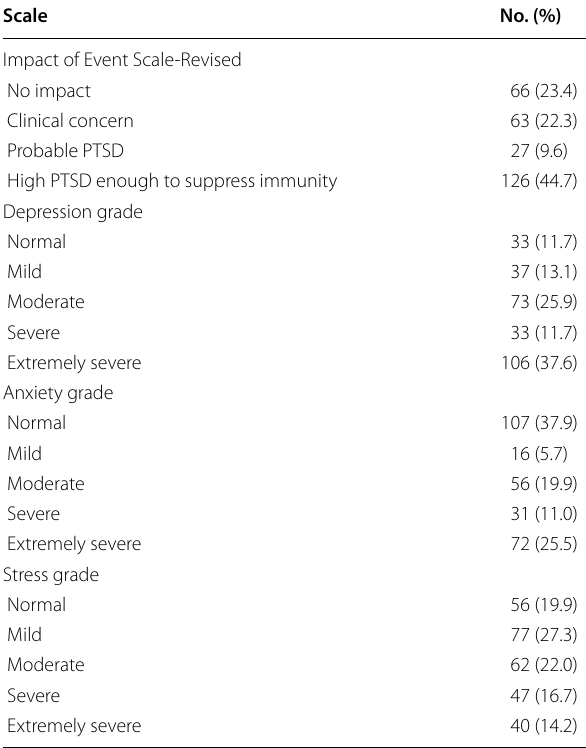
Table 2 Results of different scales among the studied group Scale Impact of Event Scale-Revised